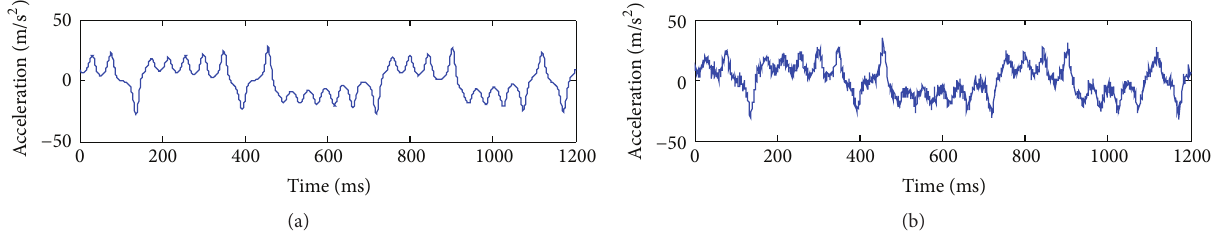
Figure 3: Lorenz time series. (a) The original Lorenz signal. (b) The noisy Lorenz signal.